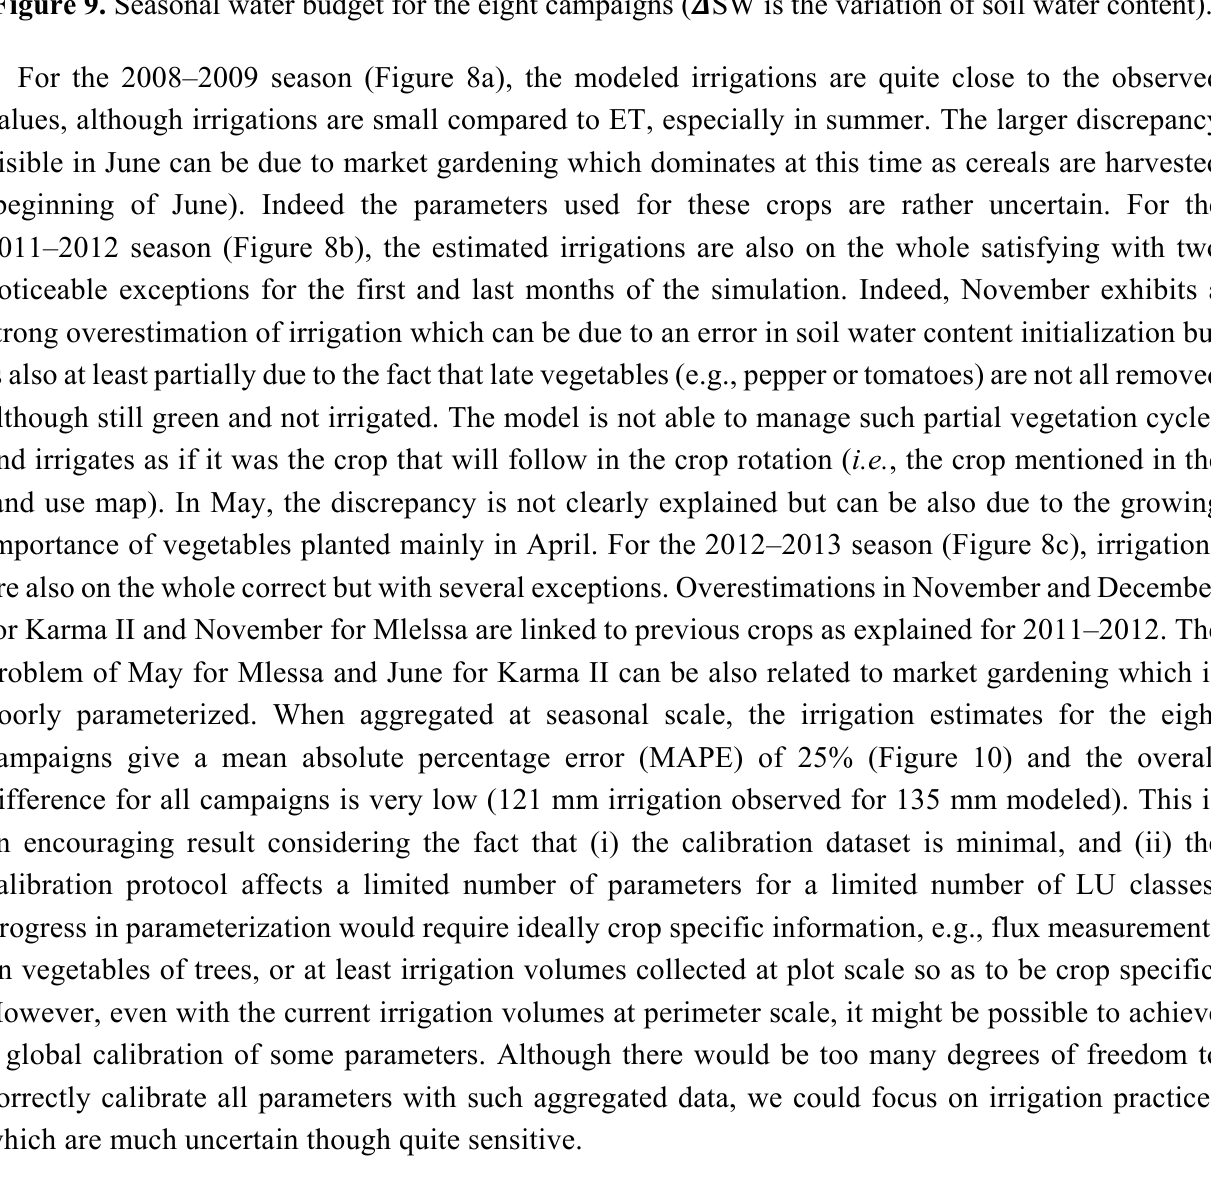
Figure 9. Seasonal water budget for the eight campaigns ( (cid:2212) SW is the variation of soil water